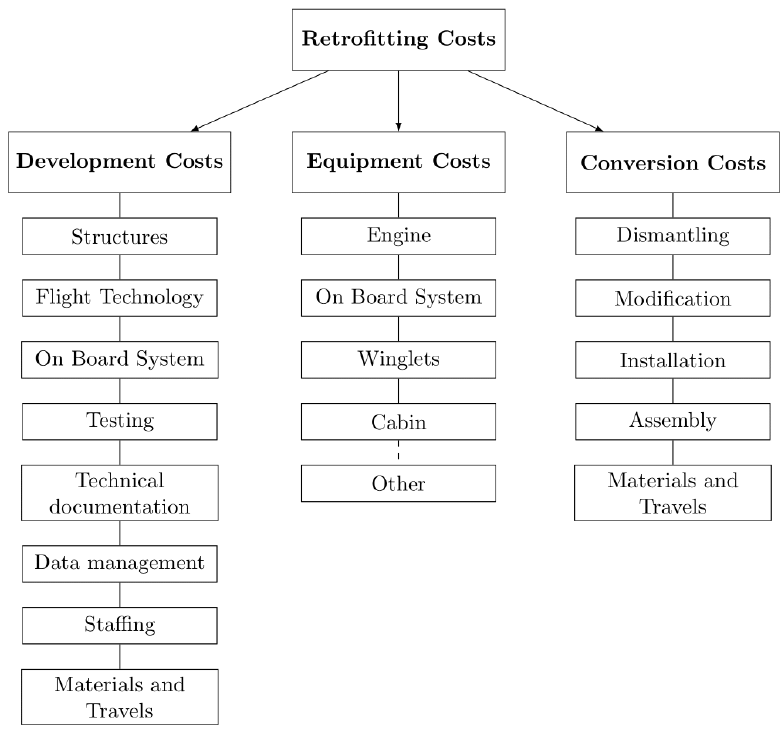
Figure 1. General representation of the retrofitting cost breakdown.